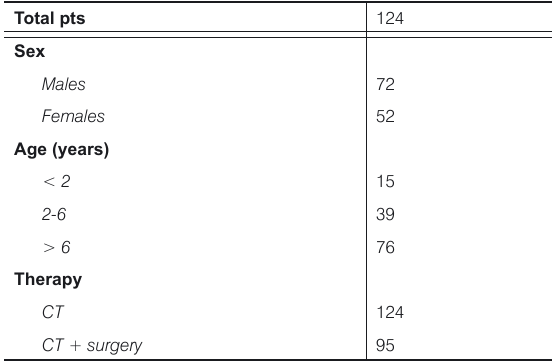
Table 4. Patient characteristics.